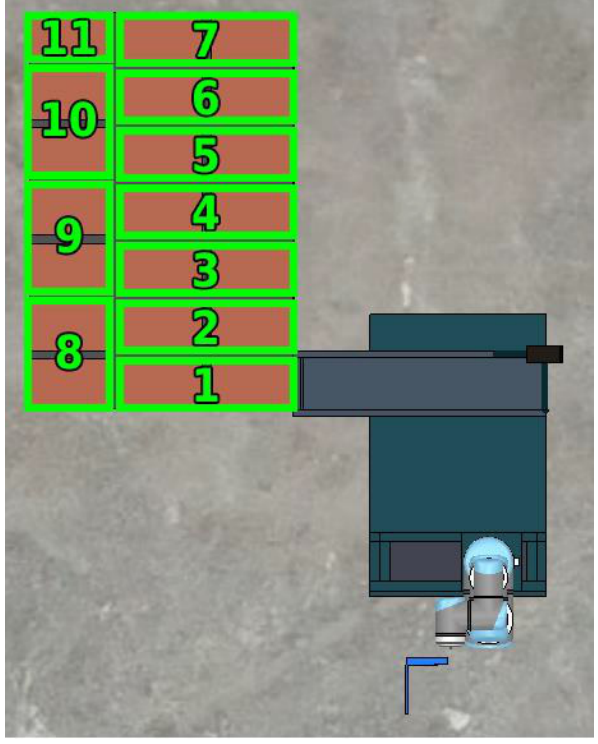
Figure 4. The grid of 21 boxes named according to the order of